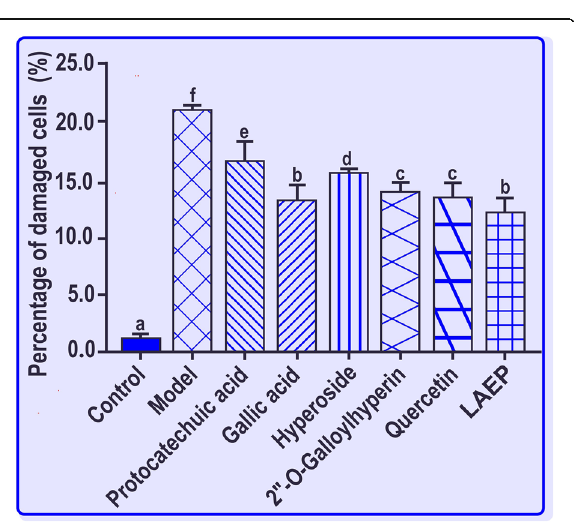
Fig. 5 LAEP and its five phenolic components protect bmMSCs against Fenton-induced apoptosis. The percentage of damaged cells was assessed using a flow cytometric assay. Experiments were performed with three different batches of cells and each batch was tested in triplicates. Data are calculated as the mean±SD values. LAEP means the lyophilized aqueous extract of P. decorata . The percentages of damaged cells with different superscripts (a, b, c, d, e, or f) are significantly different ( p